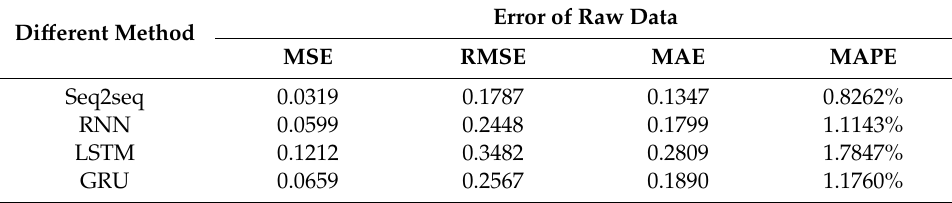
Table 4. The comparison of the prediction errors of the raw data under different algorithms.